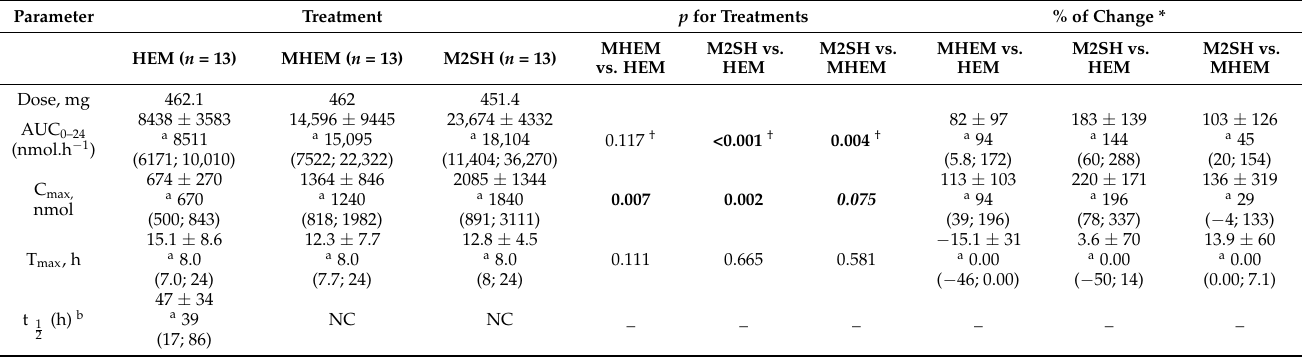
Table 5. Non-compartmental single-dose kinetics of Hesperidine catabolites after Hesperidin epimeric mixture (HEM), micronized Hesperidin epimeric mixture (MHEM) and micronized 2S-Hesperidin (M2SH)